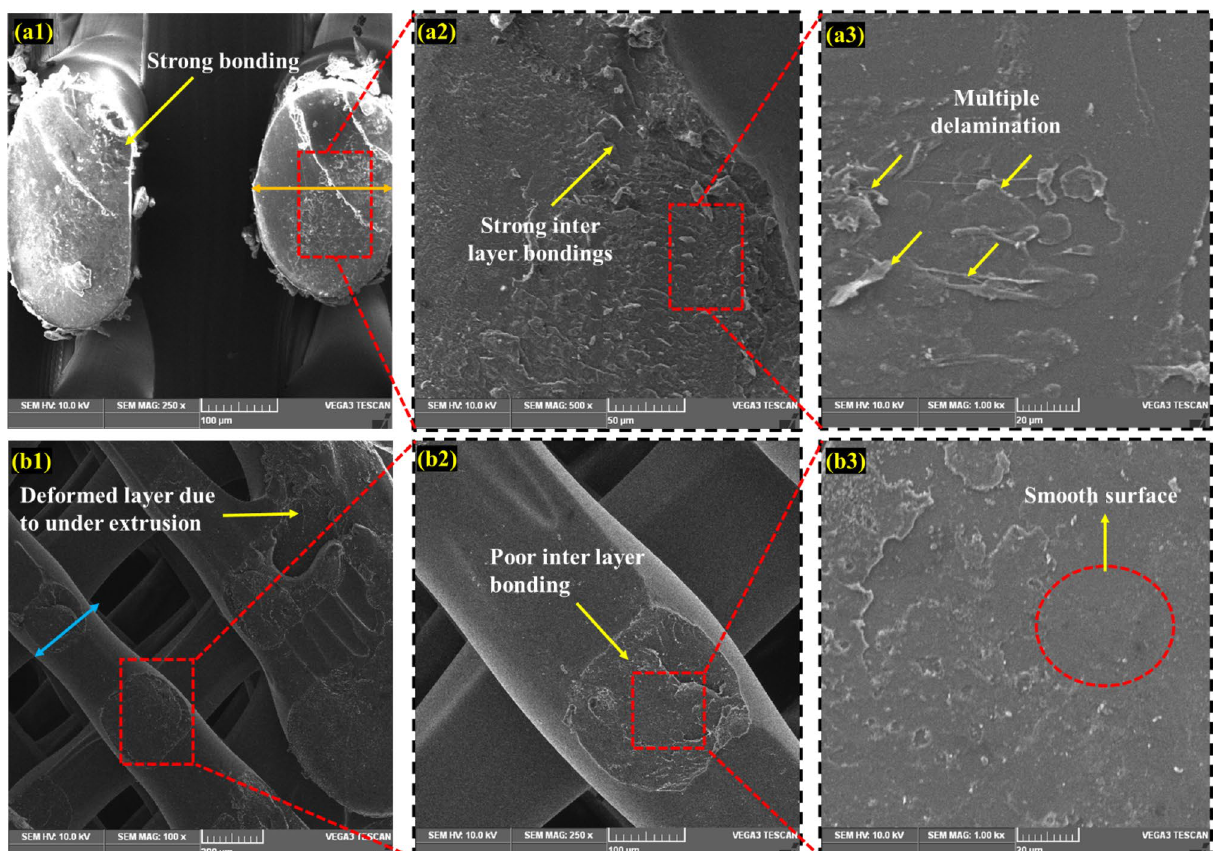
Figure 10. Comparison of fracture mechanism of tensile specimens ( a 1– a 3) optimum parameters (Layer thickness = 0.1 mm, Printing speed = 58 mm/s, Printing temperature = 199 °C), ( b 1– b 3) un-optimum parameters (Layer thickness = 0.2 mm, Printing speed = 70 mm/s, Printing temperature = 195